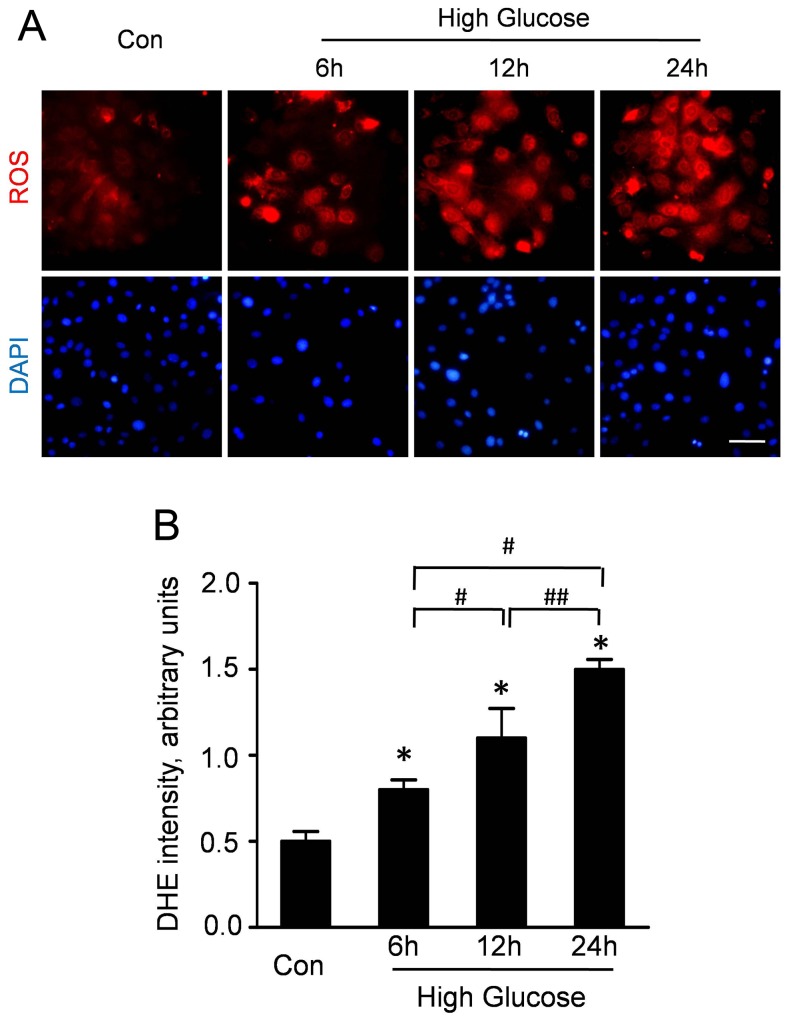
High glucose increases ROS production in CMECs.A: Representative immunofluorescence imagines of ROS formation (red fluorescent) and DAPI (blue fluorescence) in CMECs under high glucose condition for the indicated time points. (Scale bars: 50 µm). B: The average fluorescence intensity of DHE in each group. (n = 5, *p<0.05 vs. Control, #p<0.05 vs. High glucose for 6 h, ##p<0.05 vs. High glucose for 12 h).